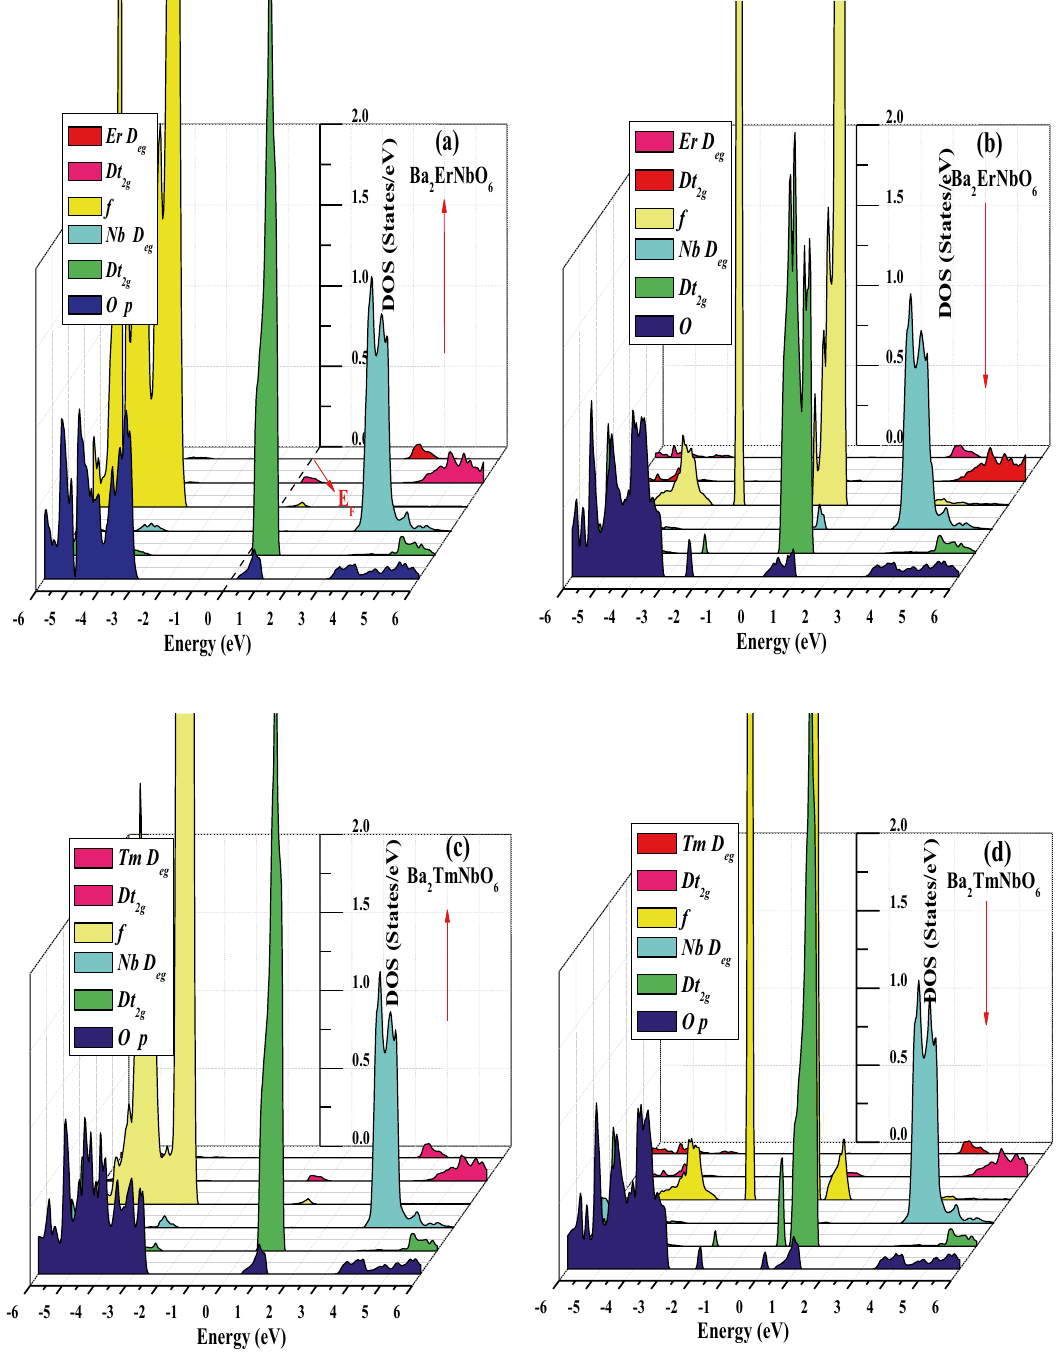
Figure 6. ( a , b ) Spin-polarised partial density of states ( pDOS ) of Ba 2 ErNbO6 via GGA + mBJ potential scheme, where zero at x axis designates the Fermi-Level (E F ). ( c , d ) Spin-polarised partial density of states ( pDOS ) of Ba 2 TmNbO 6 via GGA + mBJ potential scheme where, zero at x axis designates the Fermi-Level (E F